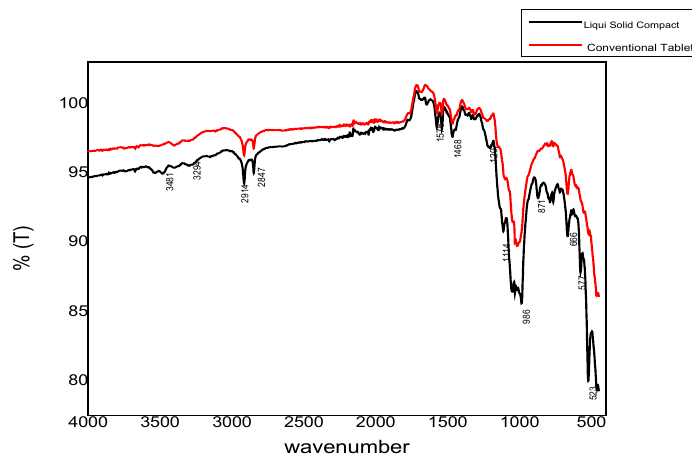
Figure 6. FTIR spectrum for both liquisolid and conventional tablets.